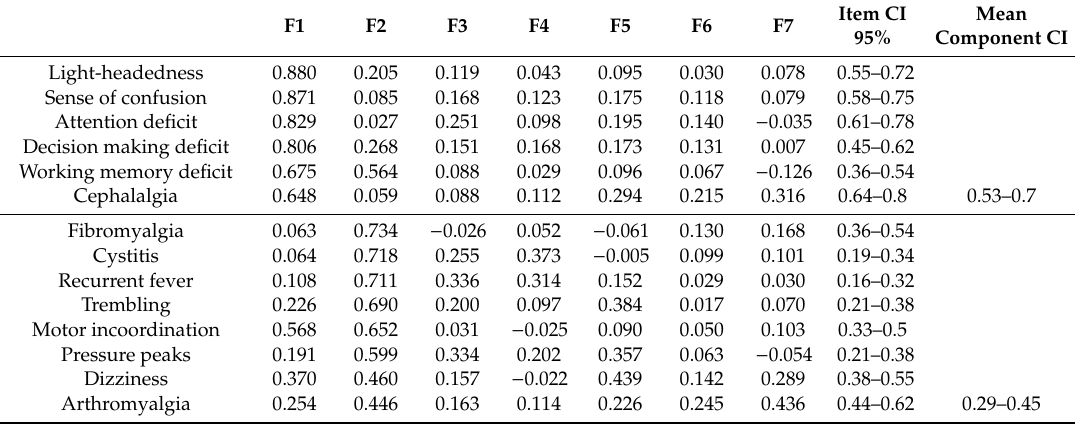
Table 3. Categorical principal component analysis: rotated component